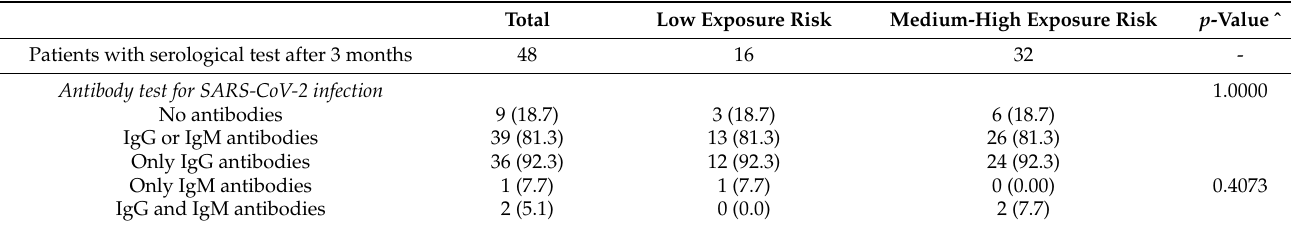
Table 5. Antibody test for SARS-CoV-2 infection in subjects with altered immunological profile, peformed after 3 months from